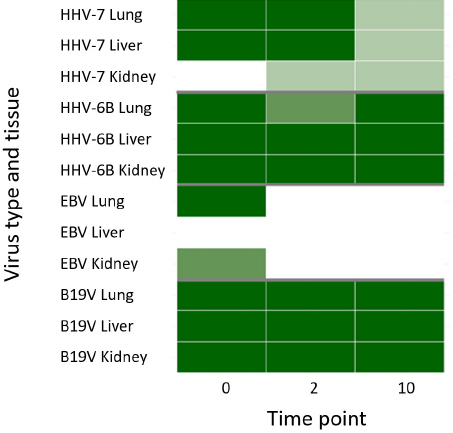
Figure 5. Concordance of qPCR and NGS. Represented are the positive viral findings in frozen (0) and FFPE samples of days 2 and 10 and examined by qPCR and NGS in one individual. They are in dark (both qPCR and NGS positive), medium (only qPCR positive) light (only NGS positive), and white (both qPCR and NGS negative).